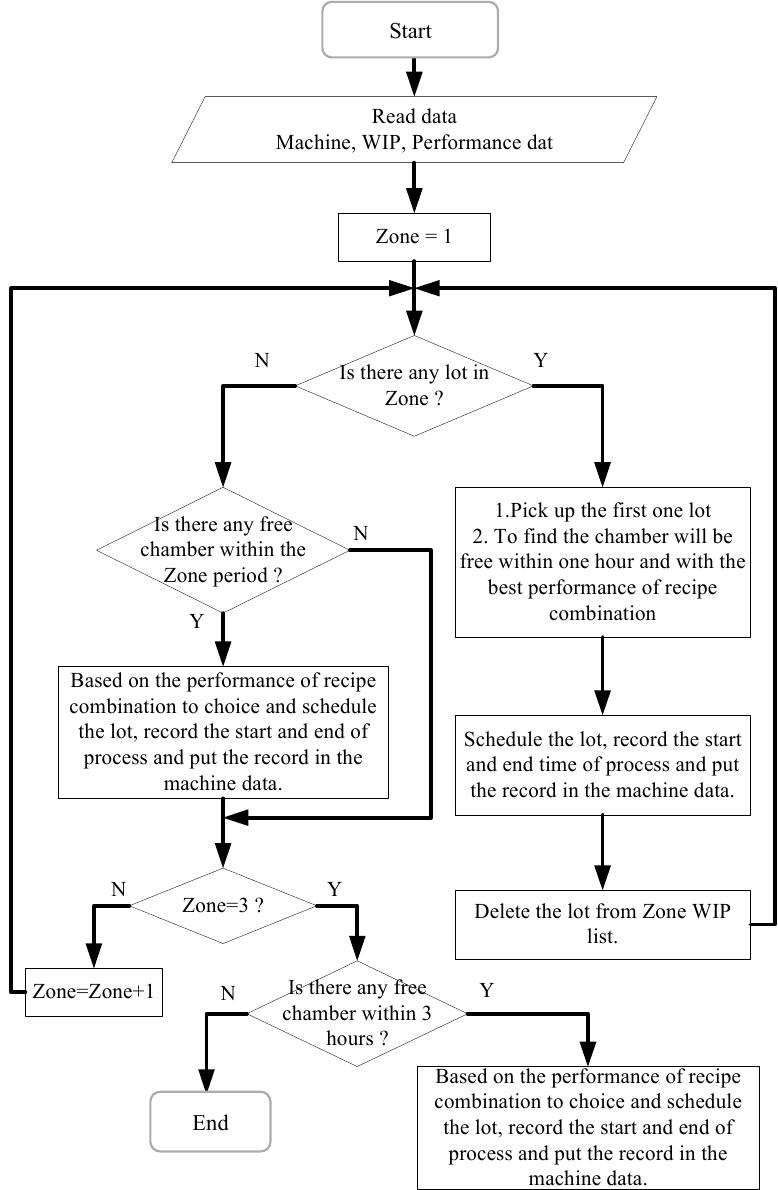
Figure 3. Flowchart of short-term scheduling algorithm for cluster tool.